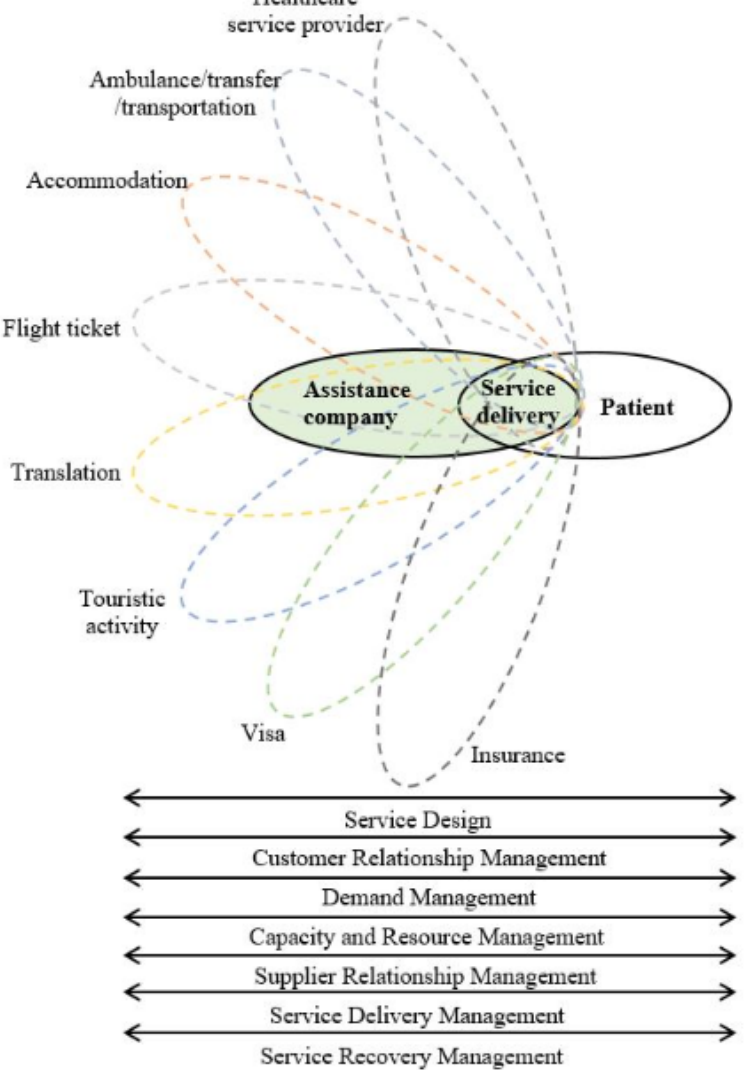
Figure 2. Proposed MTSSC